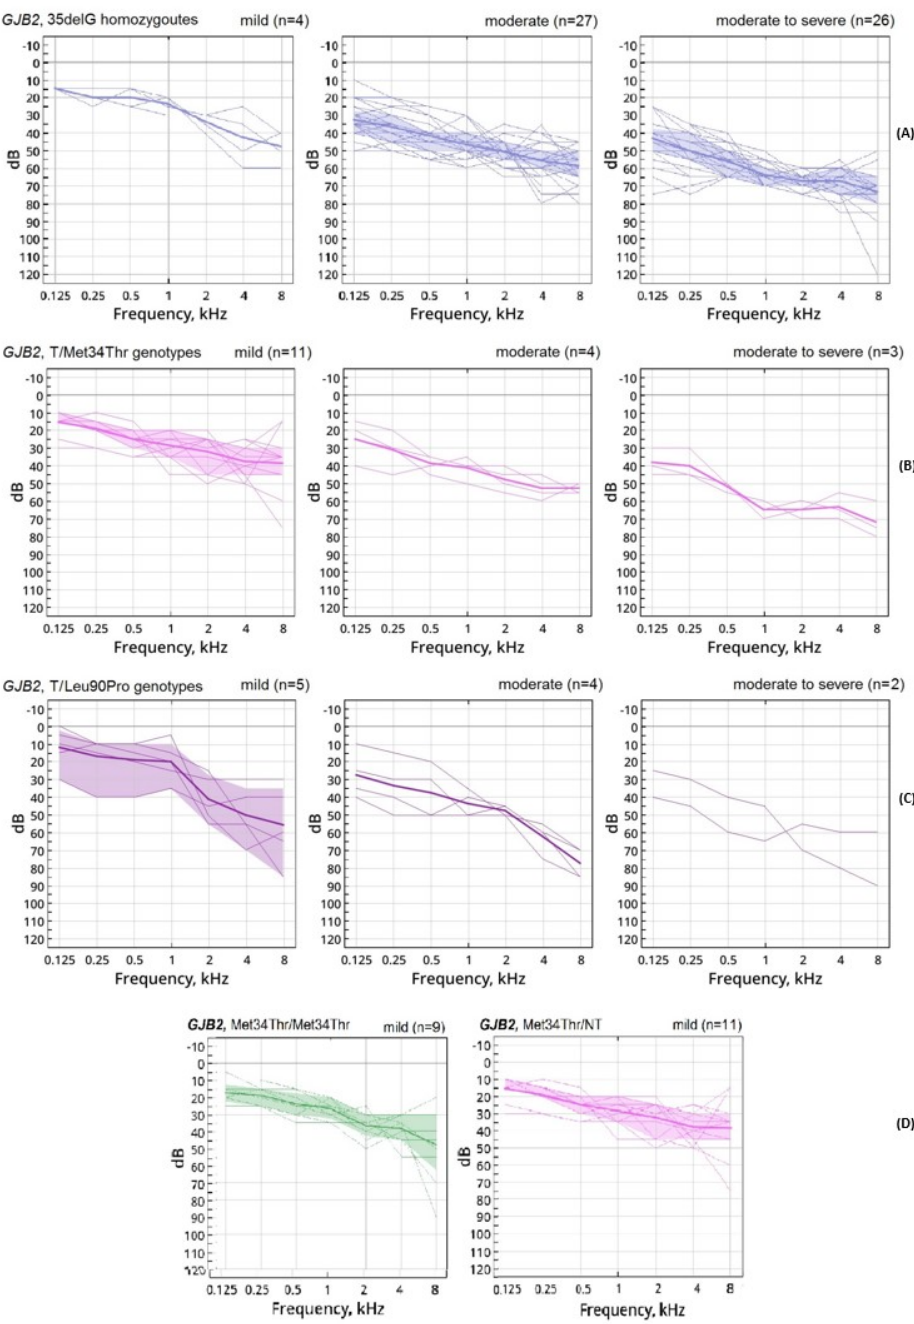
Figure 3. The audiogram profiles for different GJB2 genotypes: ( A ) genotype homozygous for the c.35delG mutation (T/T); ( B ) genotype with a heterozygous p.Met34Thr variant in the second allele (T/NT); ( C ) genotype with a heterozygous p.Leu90Pro variant in the second allele (T/NT); ( D ) genotype with a homozygous and heterozygous Met34Thr variant (NT/NT). The thin lines represent all patients’ audiograms on the better hearing ear. The bold line connects the average values of the hearing thresholds at each frequency, colored area includes quartiles intervals.